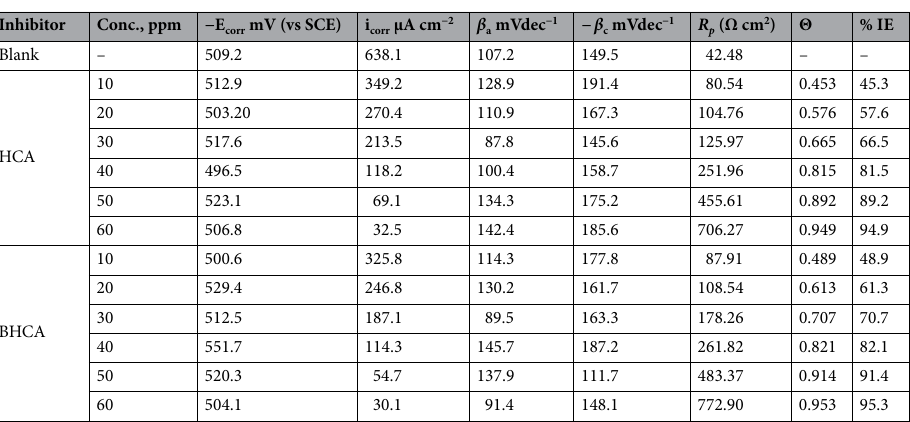
Table 6. PDP data of CS in 1 M HCl with and without altered doses of HCA and BHCA at 298 K.